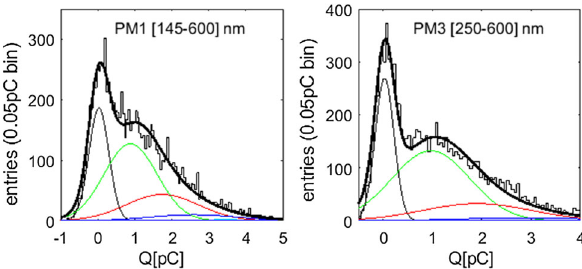
Fig. 5 Signal-integral distributions of two PMs obtained in luminosity conditions corresponding to about one photon per 100 ns time window (regulated with a pulsed LED). The single-photon charge distribution (green curve) is assumed to be Gaussian and multi-photon ( n ) peaks are fitted to its n -convolutions, with integral values bound through Pois- son statistics (noise pedestal: thin black line; 2-photon: red; 3-photon: blue). The average value and uncertainty of the single-photon charge is obtained from 3–4 fits with light yields around the ones shown here of a square signal down to 40 ns width. Data was then taken